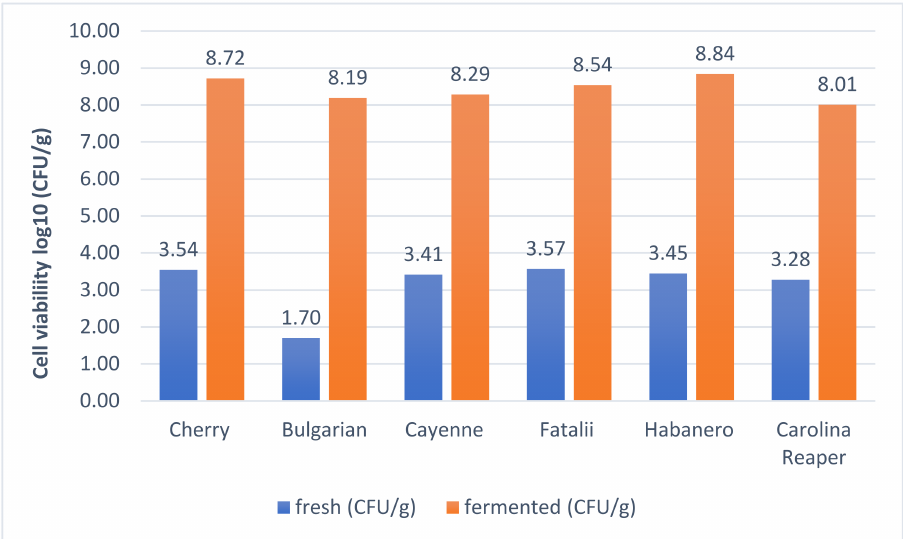
Figure 2. Viability assay of lactic acid bacteria in day 0 and day 21.